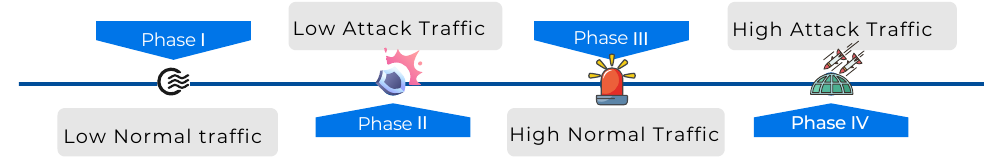
Figure 7. Traffic generation